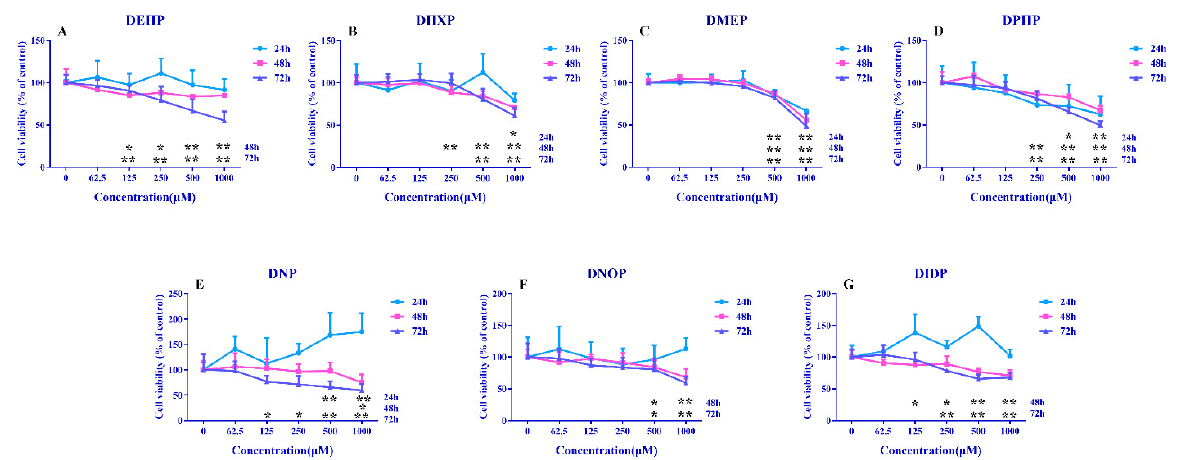
Figure 1. The influence of PAEs on cell viability. Cells were treated with 62.5, 125, 250, 500 and 1000 µ M PAEs for 24 h, 48 h and 72 h. ( A ): DEHP, ( B ): DHXP; ( C ): DMEP; ( D ): DPHP; ( E ): DNP; ( F ): DNOP; ( G ): DIDP. Data are expressed as mean ± SD, n = 6. * p < 0.05, ** p < 0.01 versus the control group.